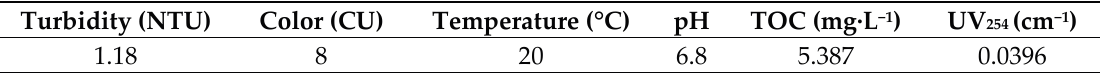
Table 5. The water quality parameters of the pretreated natural water.